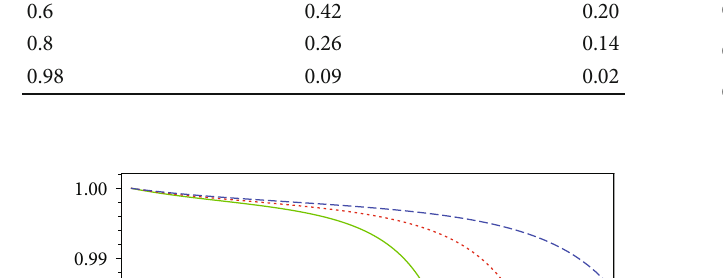
Figure 9: Considering pair production rate at zero temperature and fi xed probe brane position and di ff erent large values of scale